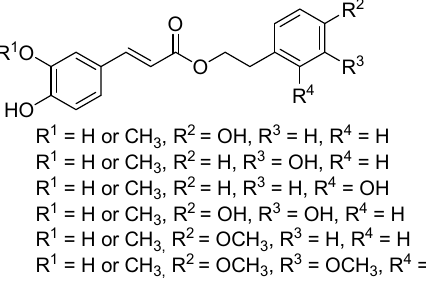
Figure 2. Analogs synthesized in this study.